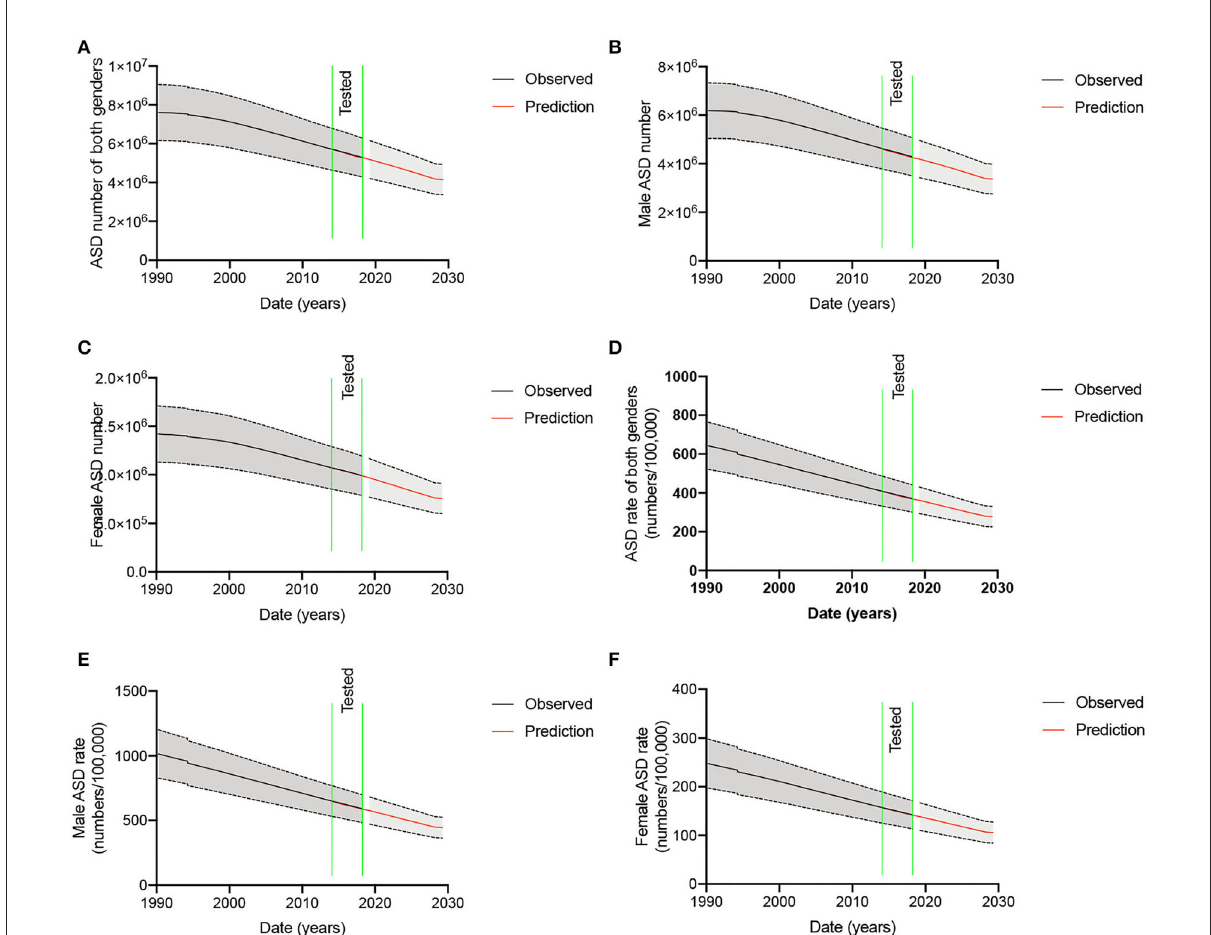
FIGURE1 ASD number and ASD rate in the mainland of China, 1990-2030. (A) ASD number of both genders. (B) ASD number of males. (C) ASD number of females. (D) ASD rate of both genders. (E) ASD rate of males. (F) ASD rate of females.